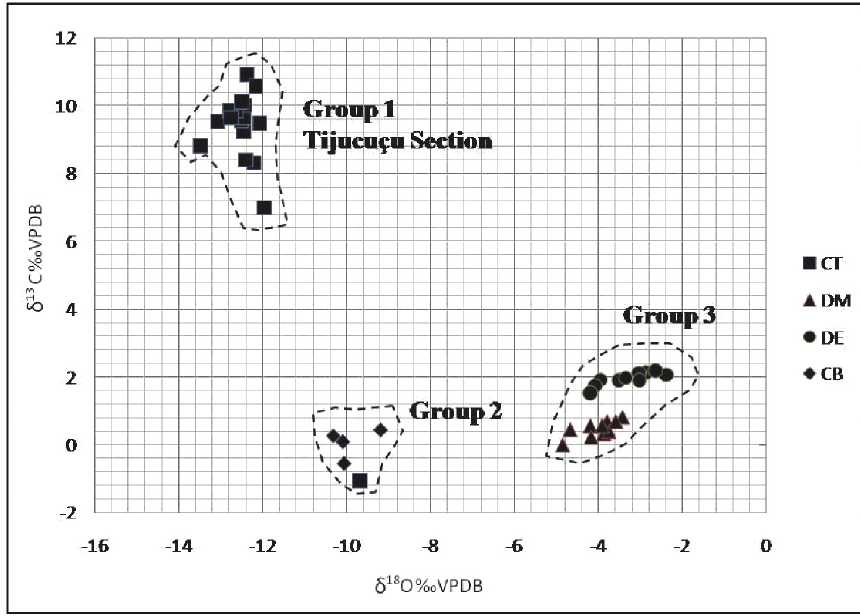
Figure 11 - δ 13 C‰ - δ 18 O ‰ plot for samples from the Tijucuçu section (CT), dolostone lenses with stromatolites (DM), dolostone of Rio Pardo Grande Formation (DE), calcareous of the Bambuí Group